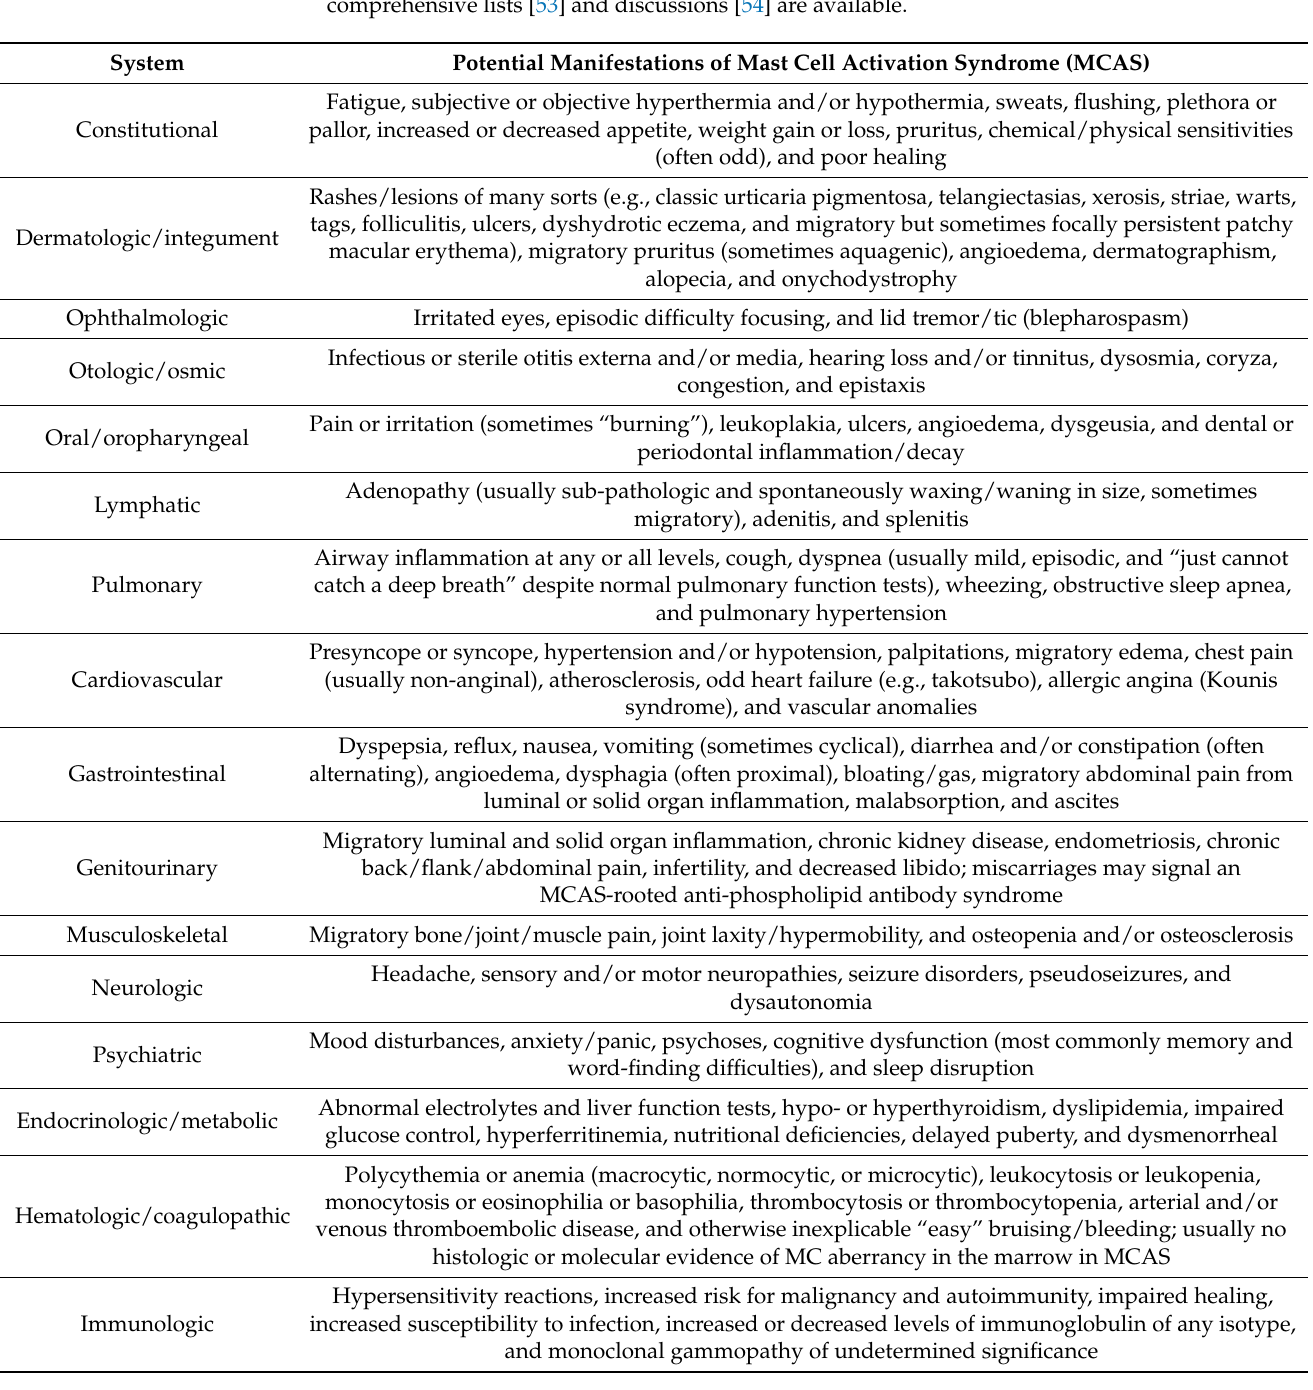
Table 2. Common symptoms and findings in mast cell activation syndrome (MCAS). Most are chronic and low-grade, some are persistent, but many are either episodic or waxing/waning. More comprehensive lists [53] and discussions [54] are